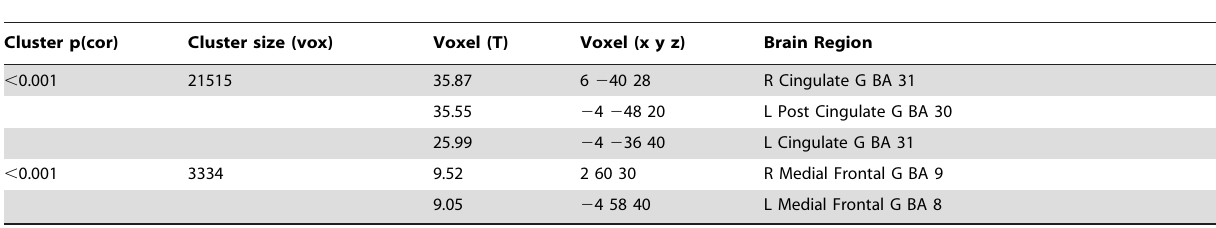
Table 1. Significant connectivity peaks for the PCC connectivity at the awake stage.